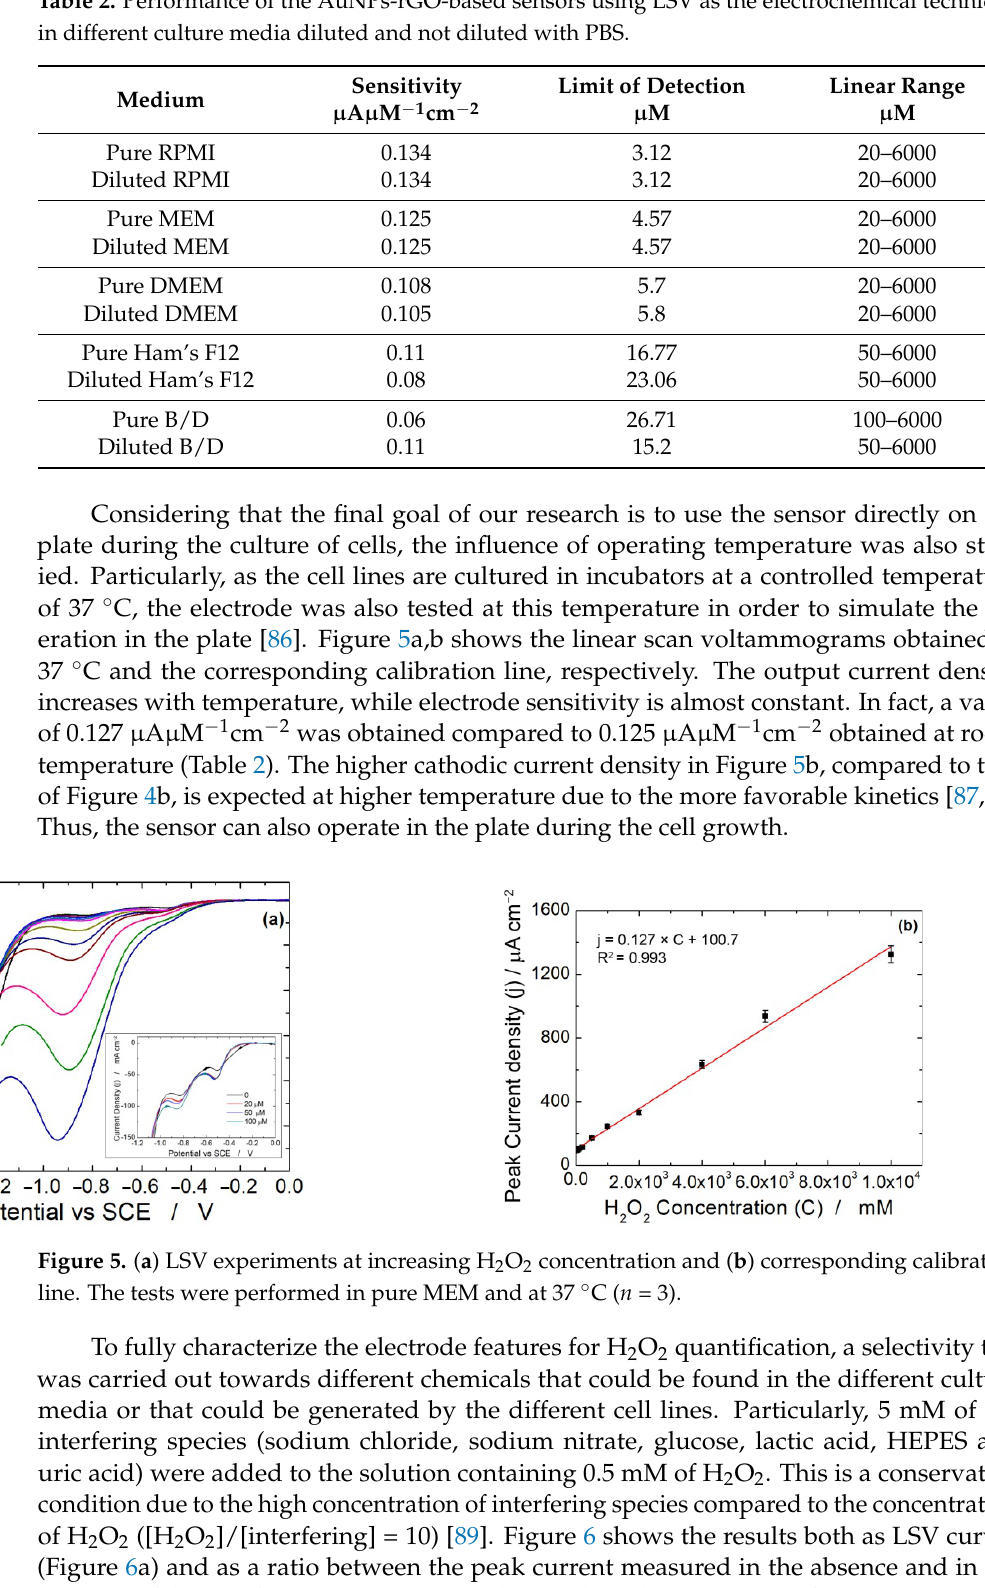
Figure 6. ( a ) LSV experiments carried out in MEM alone in the presence of 0.5 mM H 2 O 2 and 5